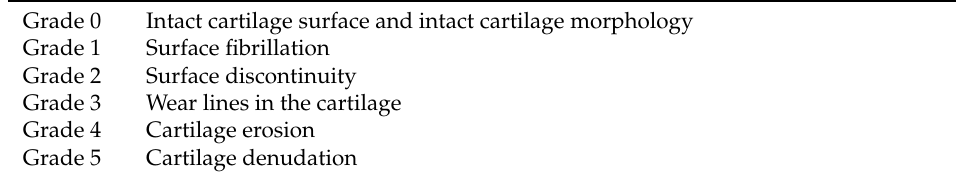
Table 2. Histopathology grading of the hyaline cartilage of the entire surface of the distal radius, according to a modified Mankin score [8].